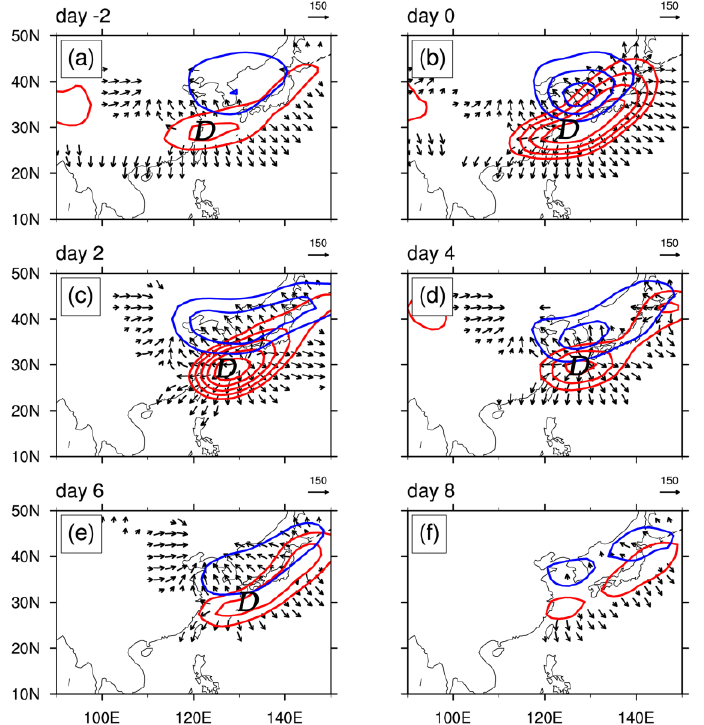
Figure 5. Composite 200 hPa divergent components of wind field (vector, units: m s −1 ), velocity potential (red contours are from 2 × 10 6 to 10 × 10 6 m 2 s −1 with interval of 2 × 10 6 m 2 s −1 ) and positive vorticity (blue contours are from 2 × 10 −6 to 6 × 10 −6 s −1 with interval of 2 × 10 −6 s −1 ) in EAP/SR-C events from day −2 to day 8 with interval of 2 days ( a – f ). The letters ‘D’ represent the centers of upper-level divergence.